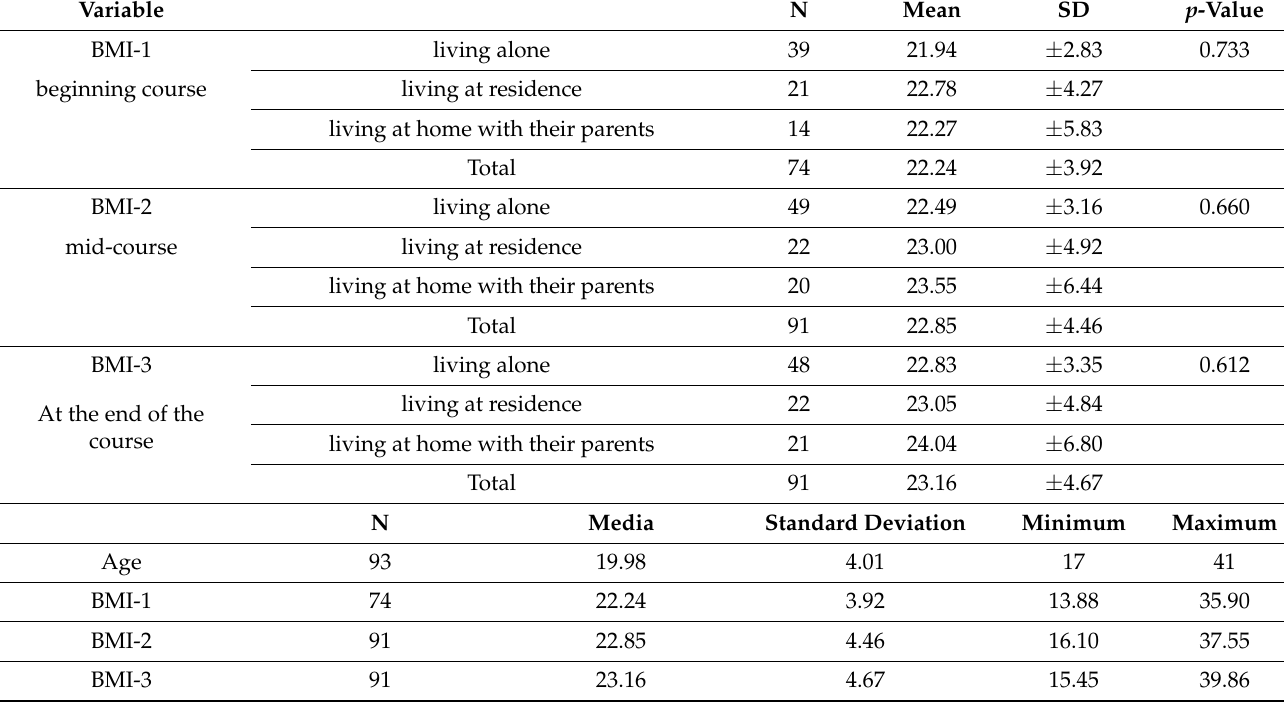
Table 2. BMI and place where students lived during the course; Descriptive statistics; Kolmogorov–Smirnov test by